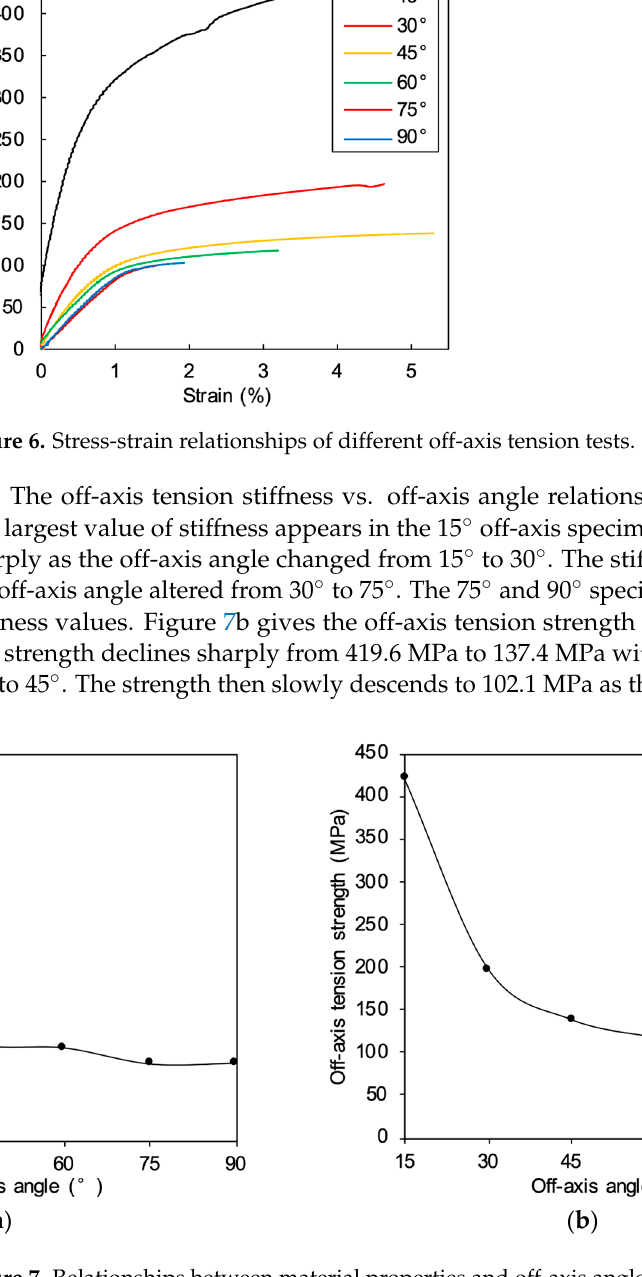
Figure 7. Relationships between material properties and off-axis angles: ( a ) Off-axis tension stiffness vs. off-axis angle curve; ( b ) Off-axis tension strength vs. off-axis angle curve.